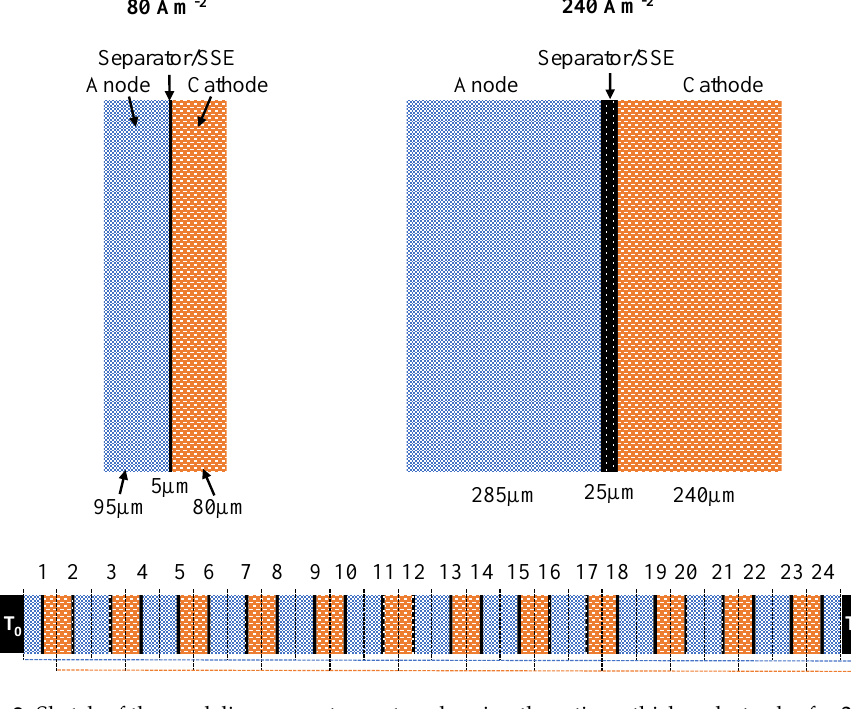
Figure 2. Sketch of the modeling geometry on top showing three times thicker electrodes for 240 Am − 2 than for 80 Am − 2 : Separator/ Solid State Electrolyte (SSE) thickness is varied between 5 and 25 µ m for both cases. Setup of the modeled 24-cell stack is shown